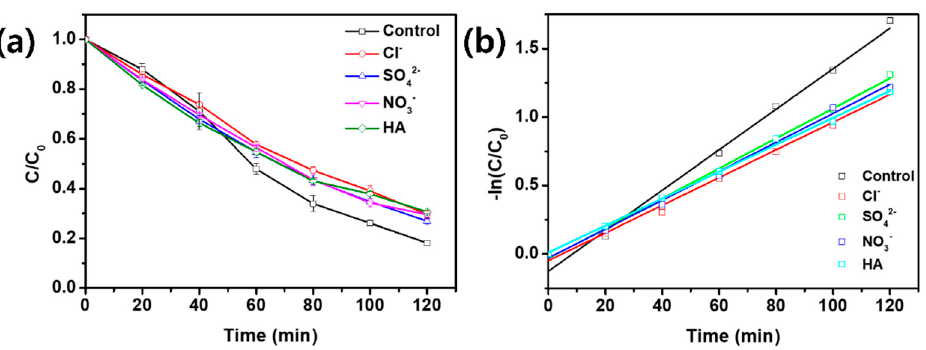
Figure 3. ( a ) OTC degradation efficiency and ( b ) pseudo-first-order kinetic plots in the presence of HA and inorganic